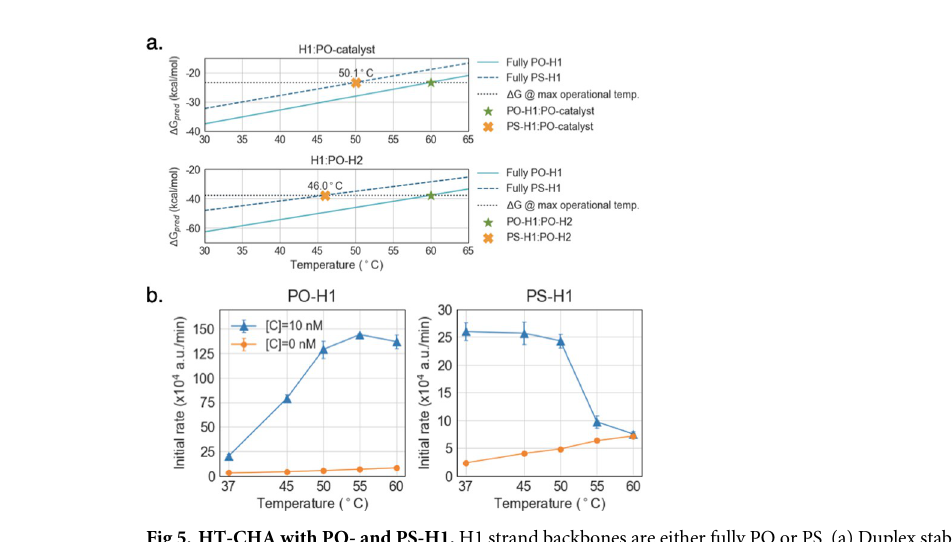
Fig 5. HT-CHA with PO- and PS-H1. H1 strand backbones are either fully PO or PS. (a) Duplex stability predictions for interactions involving PO-H1 or PS-H1 (hybridized region only, symmetrical model). Gray dotted line indicates the target stability or the duplex stability of PO-H1:catalyst or PO-H1:H2 at 60˚C, the temperature for which the HT hairpins were originally designed [31]. (b) Initial rates of HT-CHA with PO-H1 or PS-H1 at various incubation temperatures. Catalyst strand is fully PO.